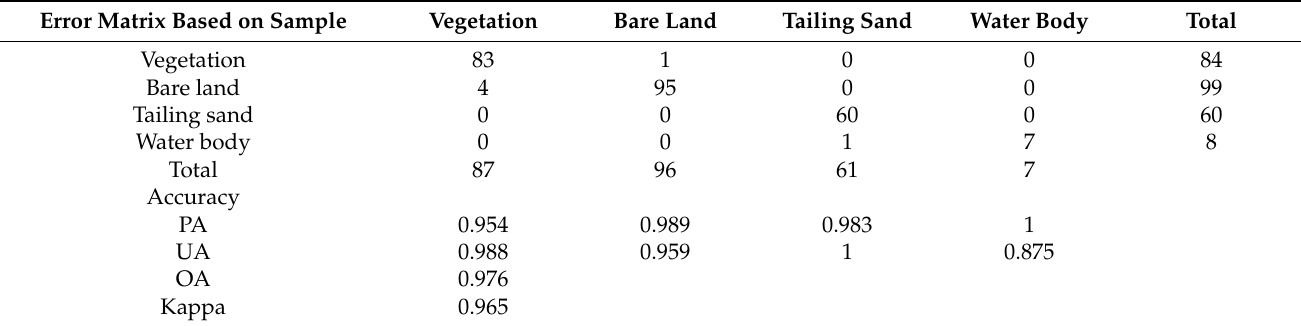
Table 5. Classification accuracy statistics of RF